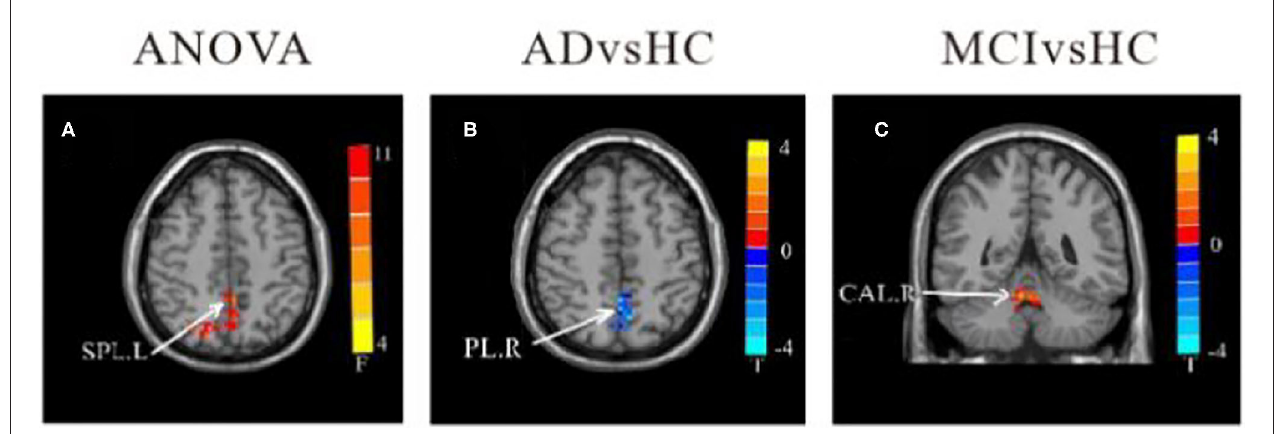
FIGURE 4 | Differences of FC values in the cerebellum left lobule IX. (A) Brain regions showing significant differences in FC of the cerebellum left lobule IX based on analysis of variance (ANOVA) analysis between HC, AD, and aMCI ( p < 0.05; the cluster size > 100 voxels). (B,C) The results of post-hoc two-sample T -tests in voxel-wise analysis (Bonferroni corrected, cluster size ≥ 30 voxels, p < 0.05). AD, Alzheimer’s disease; aMCI, amnestic mild cognitive impairment; HC, healthy controls; SPL, superior parietal lobe; PL, parietal lobe; CAL, cerebellum Anterior lobe; L, left; R, right.